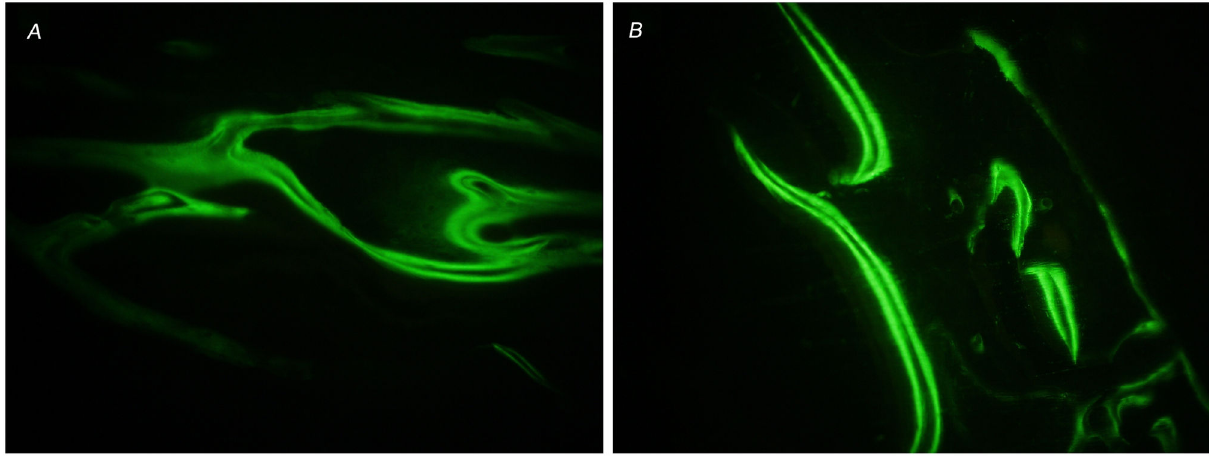
Figure 7. Double lines of fluorescent labels showing bone mineral deposition interval in in vivo test . A) Control group with a bone mineral deposition rate of 3.26±0.50 µm/day. (×200). B) Sr-doped ABS group with a bone mineral deposition rate of 4.02±0.45 µm/day. (×200).